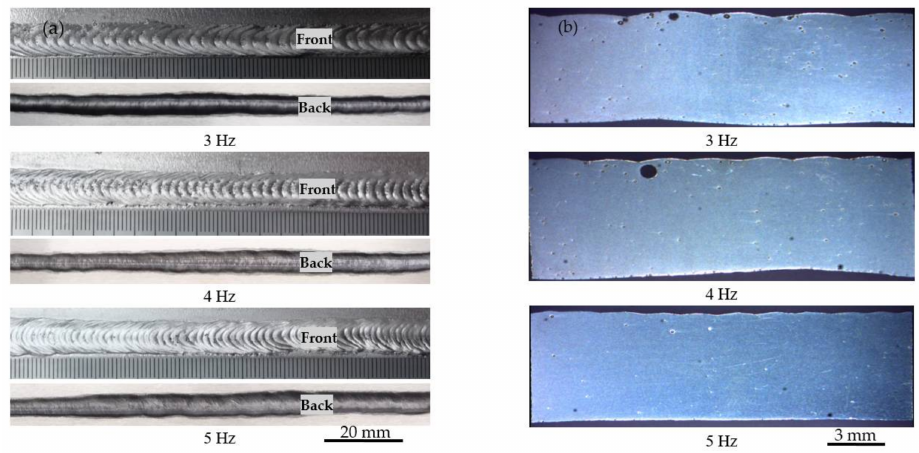
Figure 6. Weld bead shape and porosity: ( a ) weld bead shape; and, ( b ) distribution of porosity on longitudinal